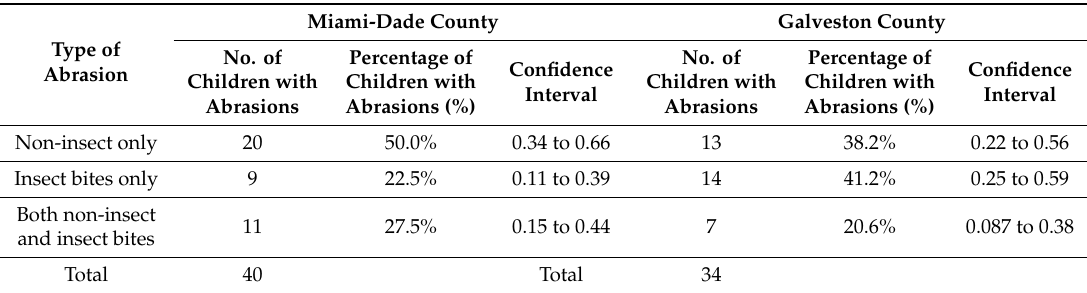
Table 3. Type of abrasions broken down by